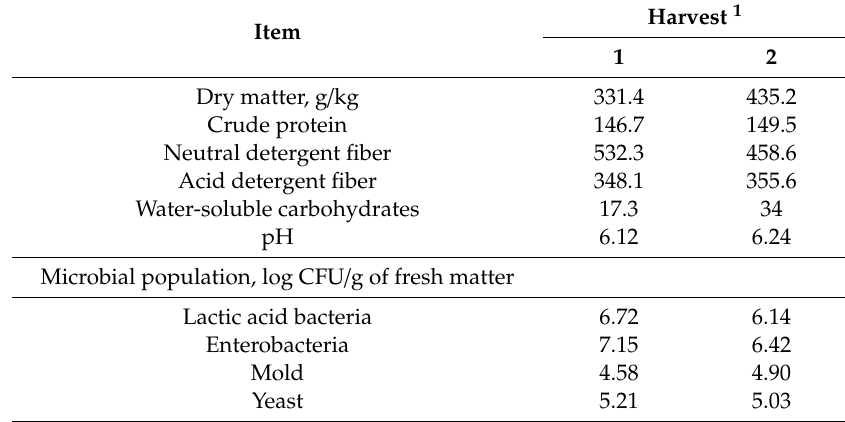
Table 1. Chemical composition (g / kg of DM) and microbial population of alfalfa forage before